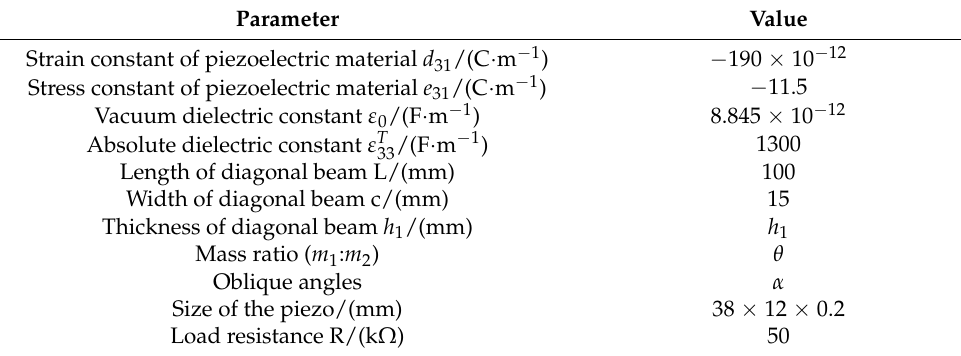
Table 3. Experimental materials and model structure parameters.